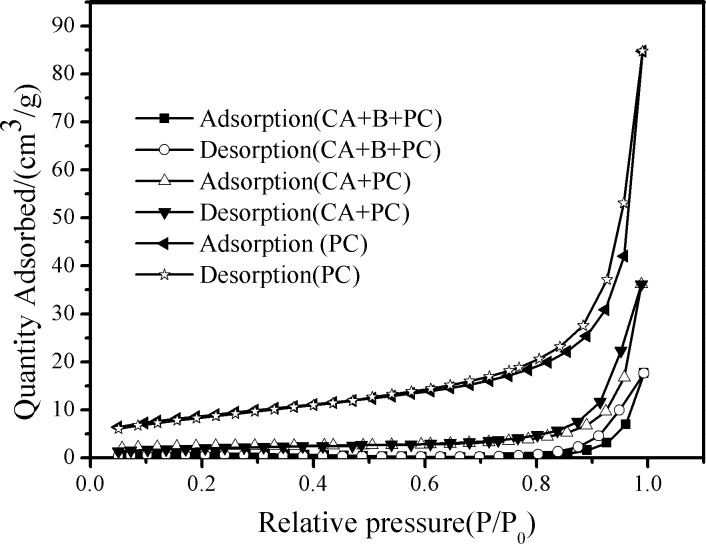
N2 sorption isotherms for CA+B+PC, CA+PC and PC beads.